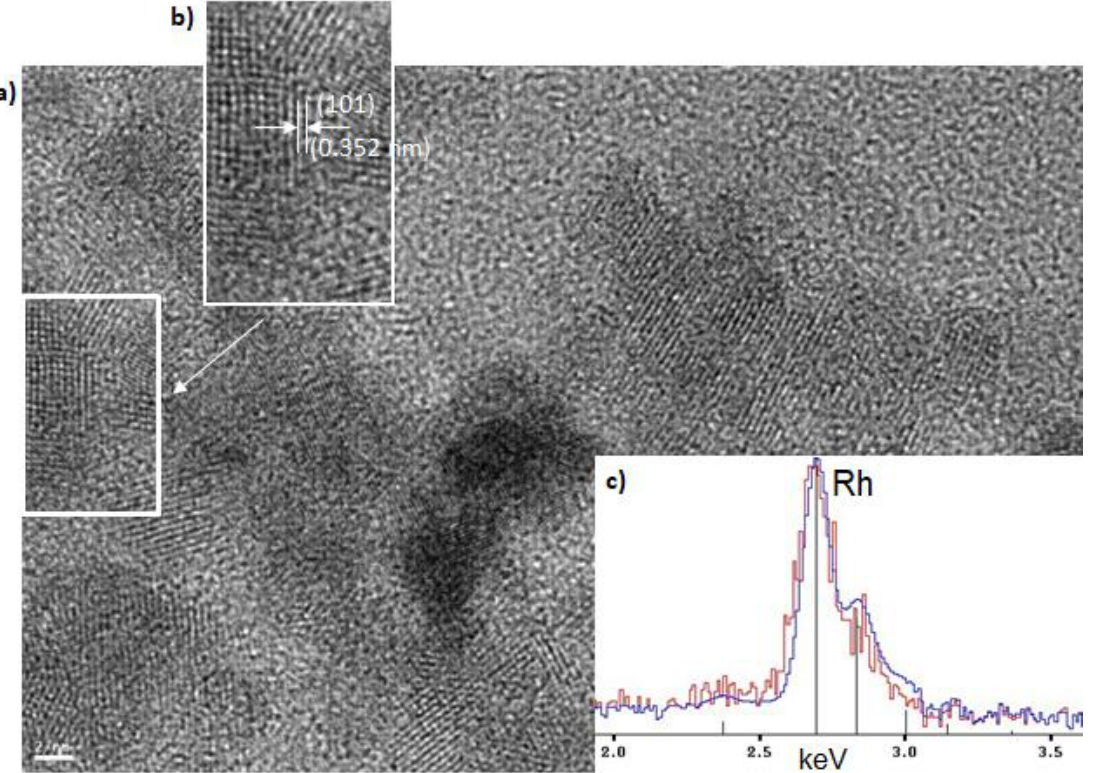
Figure 3. HRTEM micrograph. ( a ) Rh(0)NPs@TiO 2 (scale bar is 2 nm). ( b ) Magnification of an area showing the lattice planes of TiO 2 anatase. ( c ) EDX spectrum of Rh(0) particles proved by deconvolution analysis (red vs. blue curves).